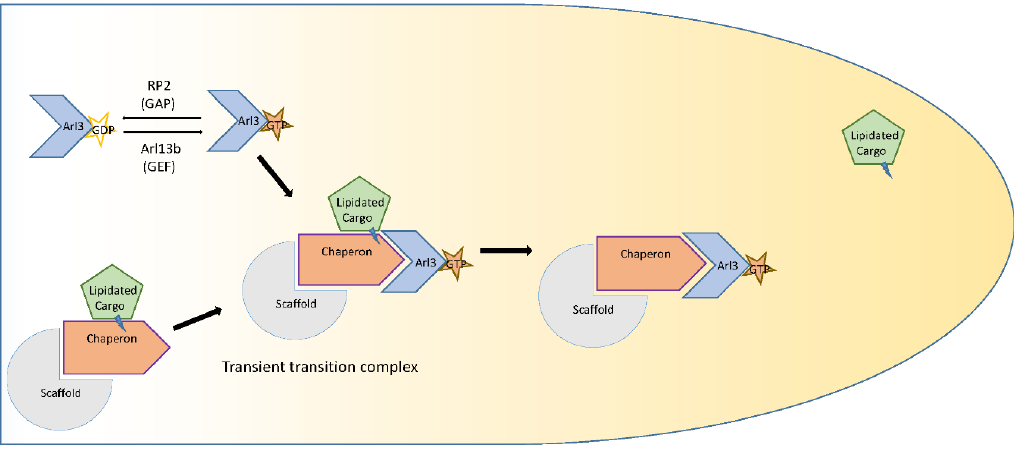
Figure 1. Schematic representation of lipidated (myristoylated/prenylated) protein delivery to the